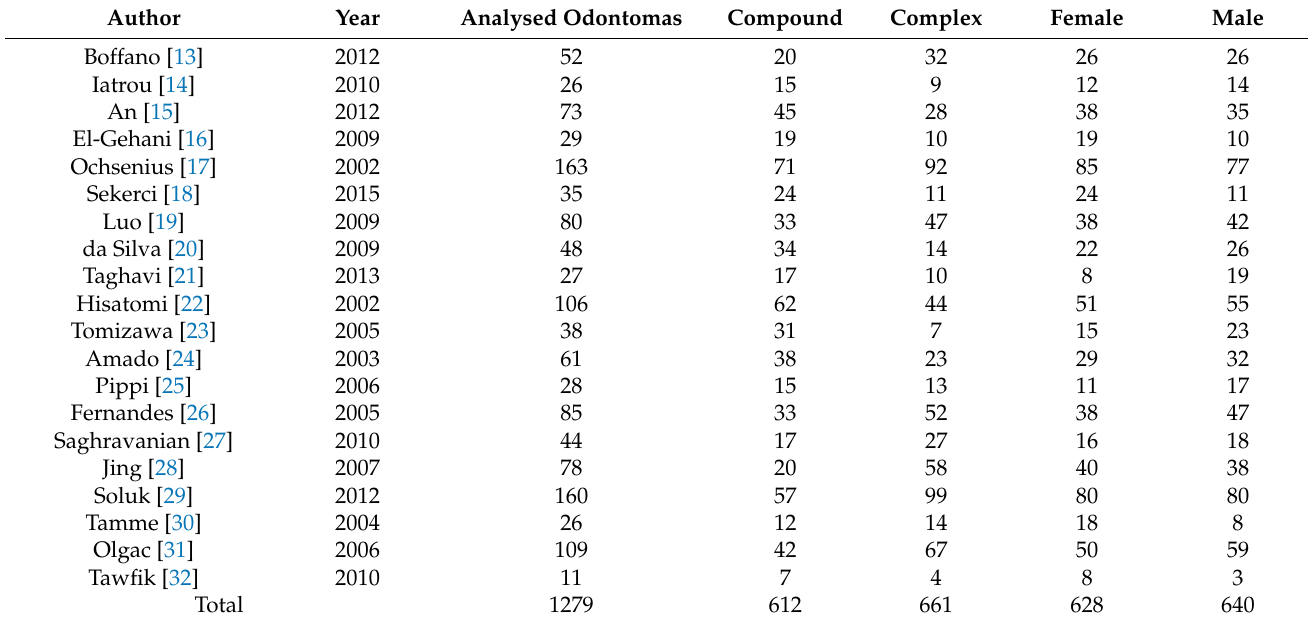
Table 1. Review of the literature related to compound and complex